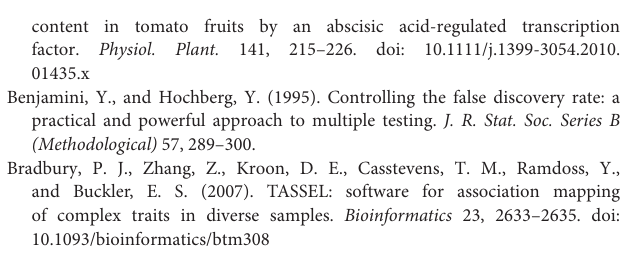
Table S2 | Detailed information for 182 SSR markers used for association mapping in this research. Table S3 | Genome-wide associations for 17 sugars, sugar alcohols and organic acids in tomato fruit estimated with K + Q (MLM) model on 174 tomato accessions (only those where P < 0.005 are listed). Table S4 | The Pearson correlation coefficients ( r ) among sugars, organic acids, nutritional traits, and volatiles. Figure S1 | Frequency distribution of the content of the detected 17 sugars and organic acids. Figure S2 | Optimal K of the population structure of all accessions based on 182 SSR markers, according to Evanno method (2005). Figure S3 | Estimates of LD ( r 2 ) over genetic distance on all chromosomes for all 174 tomato